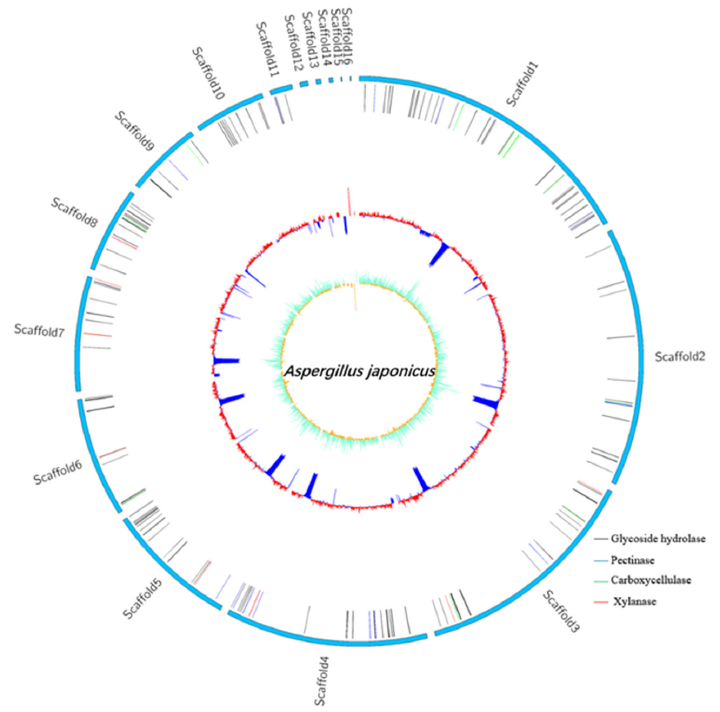
Figure 6. Genome map of A. japonicas PJ01. Table 5. The genome features of A. japonicas PJ01.